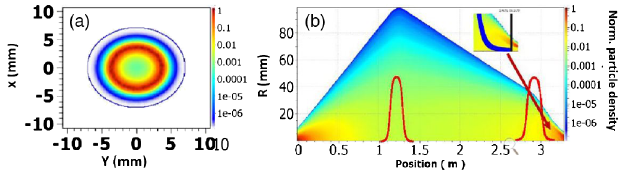
FIG. 2. (a) Transverse particle density distribution of the proton beam at the exit of the LEBT, (b) r - z particle density plot in the LEBT, showing the formation of the hollow beam in the nonlinear solenoid